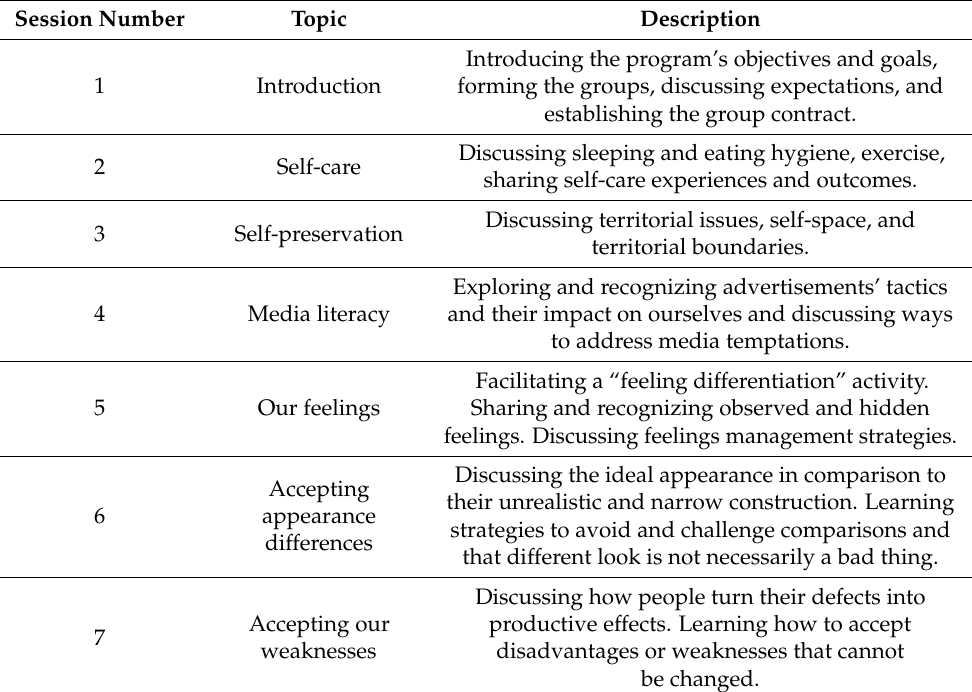
Table 1. Content and description of the program